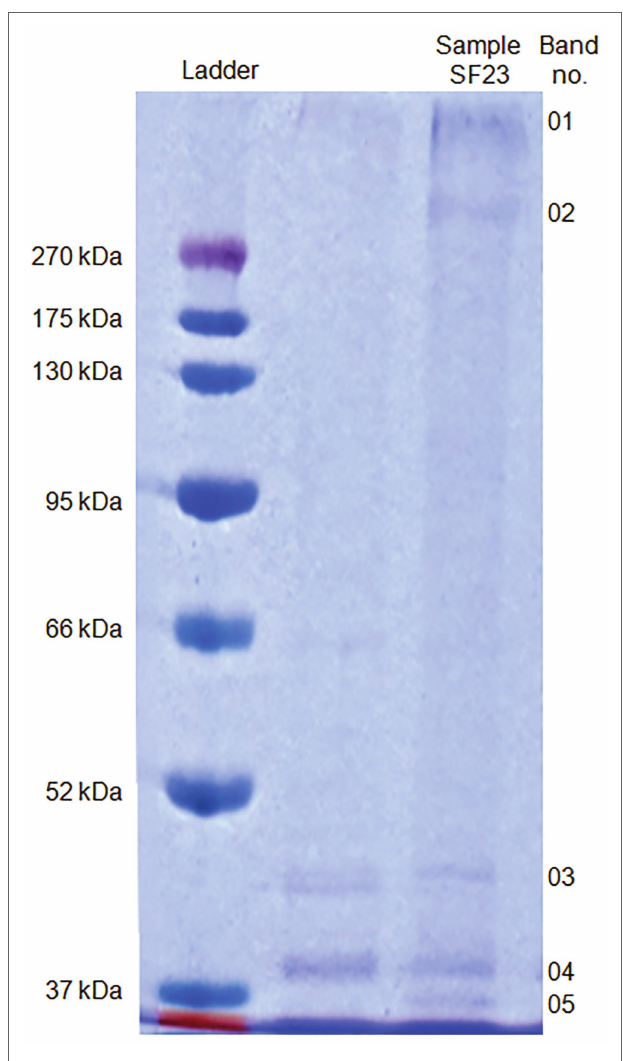
FIGURE 8 | SDS-PAGE of proteins associated with biosynthesized